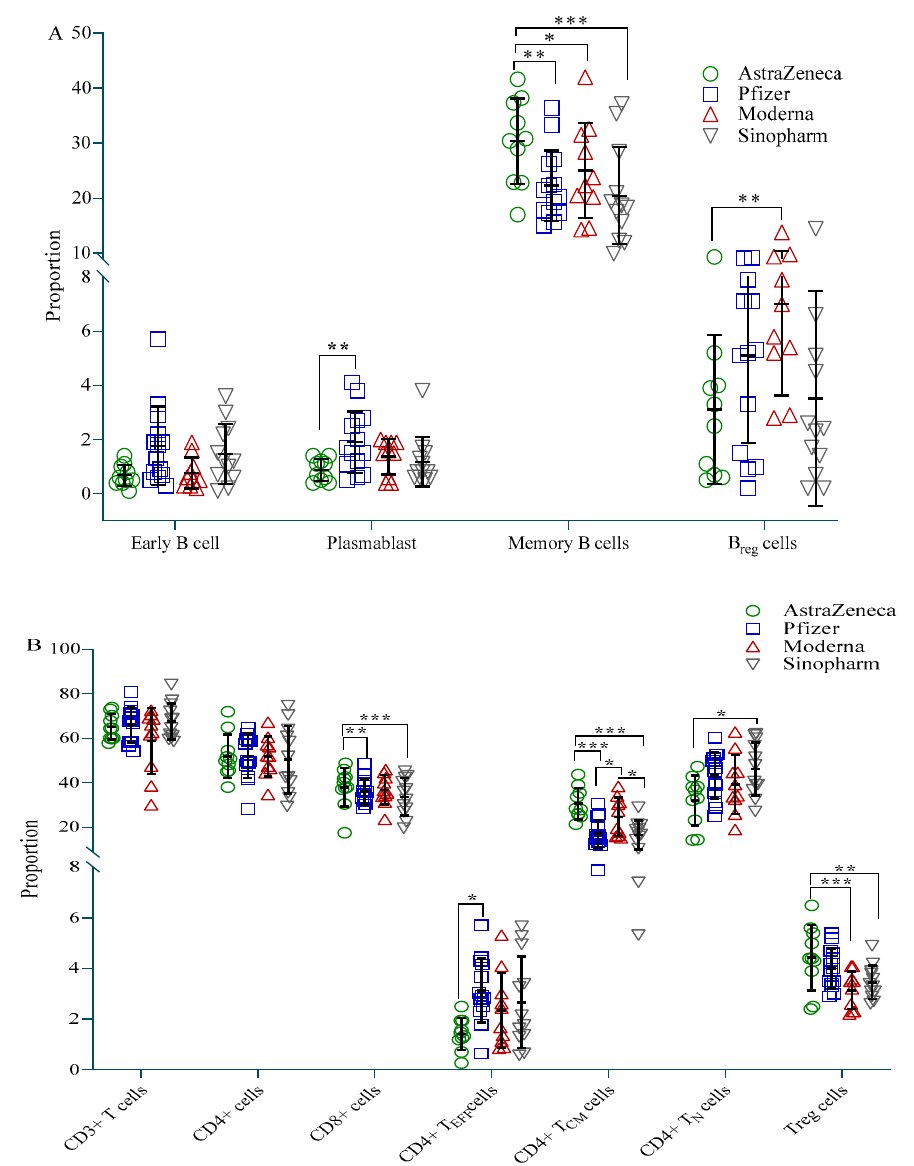
Figure 3. Proportion of immune cells in different vaccine groups. ( A ) Proportion of B cell subtypes; ( B ) Proportion of T cell subtypes. A 2-way ANCOVA was used to estimate the p -value, and the model was adjusted for age, sex, income and BMI. * p < 0.05, ** p < 0.01, *** p < 0.001 .